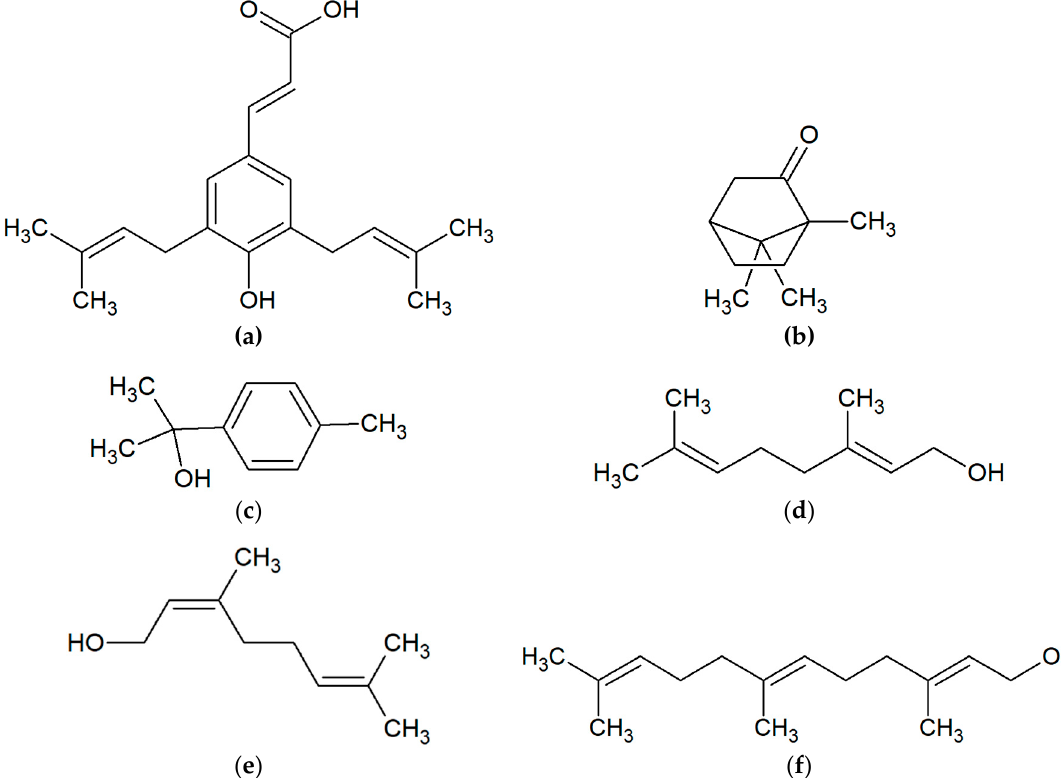
Figure 4. Substances responsible for characteristic fragrance of propolis: ( a ) phenolic compound artepillin C; terpenes: ( b ) camphor; ( c ) terpineol; ( d ) geraniol; ( e ) nerol; ( f ) farnesol.